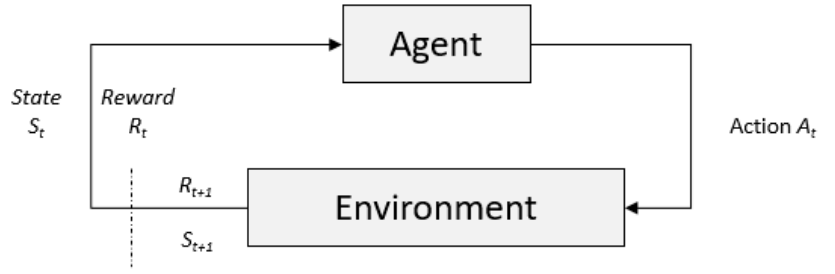
Figure 2. Agent–environment interaction in RL (adapted from [25]).